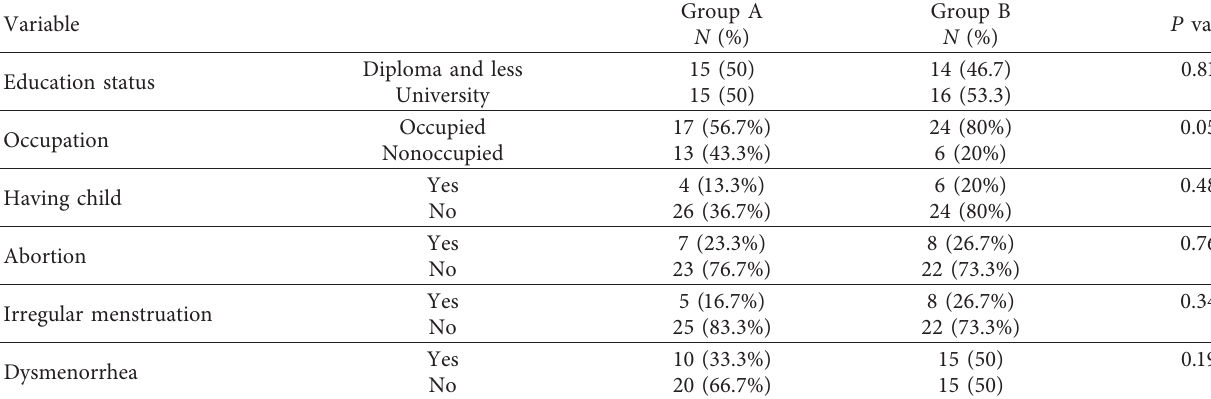
Table 1: Baseline characteristics of